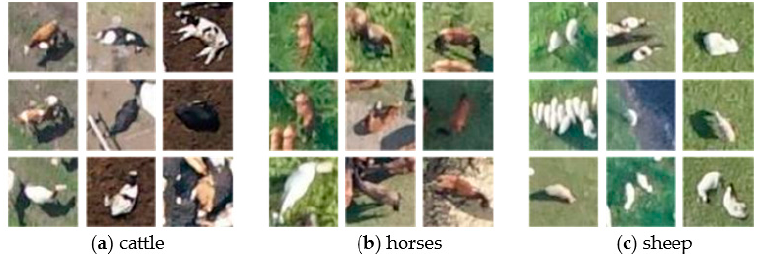
Figure 4. The object instances of the dataset. ( a ) cattle instances; ( b ) horse instances; ( c ) sheep instances.